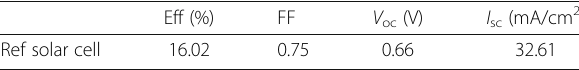
Table 1 Characteristics of a reference solar cell fabricated on the same wafer without any treatment